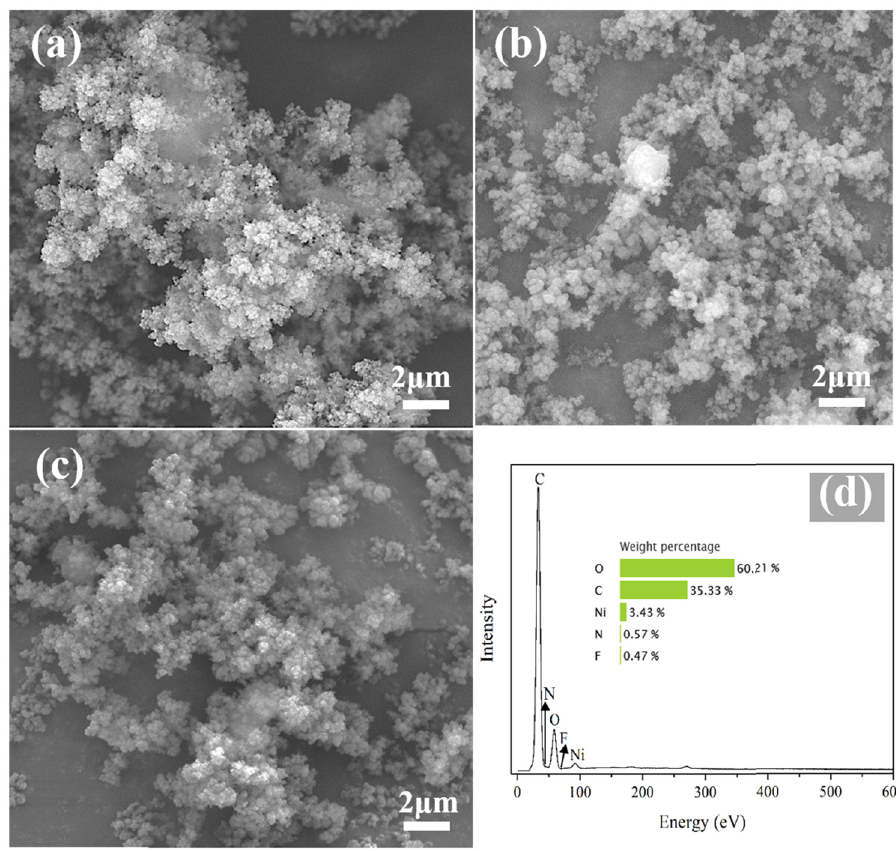
Figure 11: ( a ) SEM images of Ni ( II )- IIP 5 , ( b ) NIP 5 , ( c ) Ni ( II )- IIP 5 after adsorption, and ( d ) EDS analysis of image ( c )